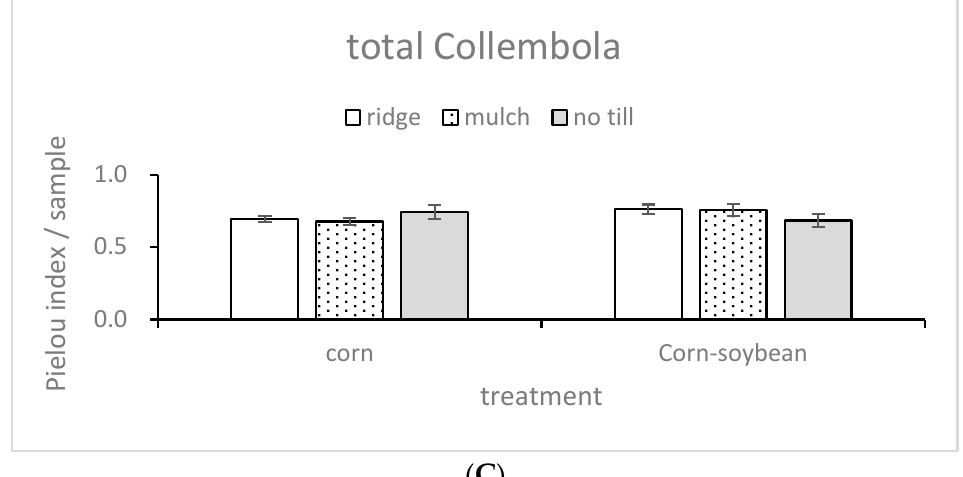
Figure 2. Analysis of variance (ANOVA) barplot of the treatments data showing ( A ) Shannon wiener index, ( B ) Simpson index, and ( C ) Pielou index of total Collembola across three tillage types (mould plow, ridge tillage, and No-tillage) in corn and corn–soybean rotation. Superscripts indicate significant differences between factors at the 0.05 level.